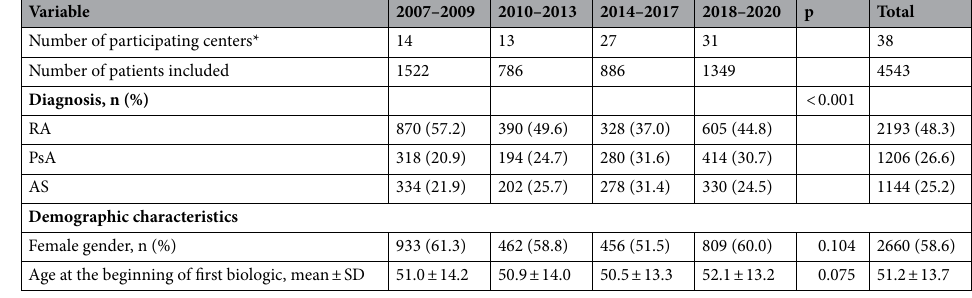
Table 1. Diagnosis and sociodemographic features at the beginning of first-line biologics treatment by time periods. *Centers that included at least one patient in this